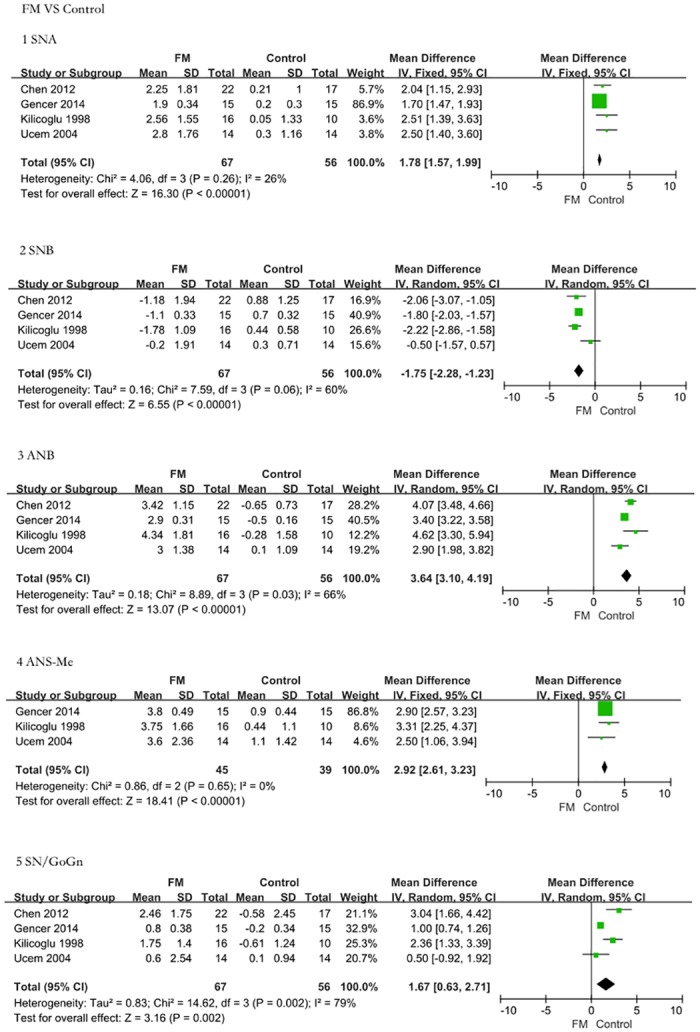
The efficacy assessment of FM treatment for Class III malocclusion versus untreated controls.The comparison was performed using five indices. 1: Angle SNA. The FM treatment group presented a greater increase in SNA than the controls (SMD = 1.78, 95% CI = 1.57–1.99, P < 0.00001). 2: Angle SNB. The FM treatment group presented a greater decrease in SNB than the untreated controls (SMD = -1.75, 95% CI = -2.28–-1.23, P < 0.00001). 3: Angle ANB. The FM treatment group presented a greater increase in ANB than the controls (SMD = 3.64, 95% CI = 3.10–4.19, P < 0.00001). 4: ANS-Me length. The FM treatment group presented a greater increase in ANS-Me length than the controls (SMD = 2.92, 95% CI = 2.61–3.23, P < 0.00001). 5: Angle SN/GoGn. The FM treatment group presented a greater increase in SN/GoGn than the controls (SMD = 1.67, 95% CI = 0.63–2.71, P = 0.002). The FM groups exhibited significant improvement in skeletal retrognathism of the maxilla.